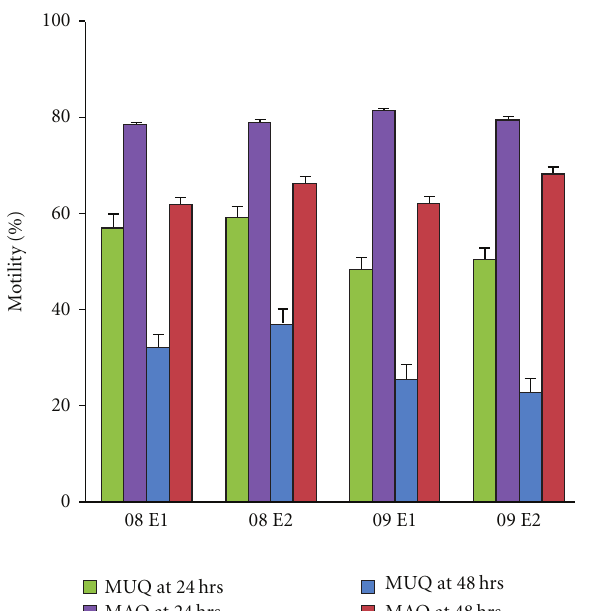
Figure 1: Motility in MUQ and MAQ at 24- and 48-hours observations in the 4 consecutive PT events. The di ff erence between MUQ and MAQ was significant ( P < . 05) in all events at 24 hours as well as 48 hours. MUQ at 24 hours (green); MAQ at 24hours (purple); MUQ at 48hours (Blue); MAQ at 48hoyrs (red).